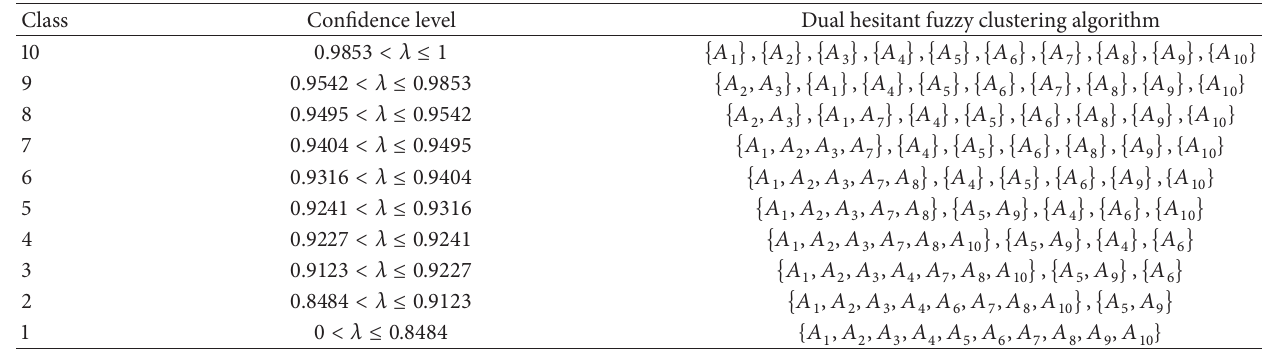
Table 7: The clustering result of 10 diamonds.